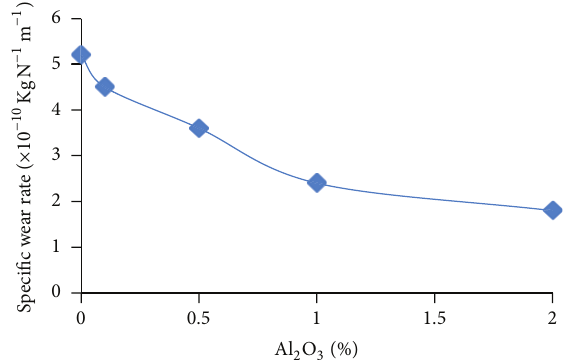
Figure 15: Variation in specific wear rate of EN-coatings as a function of Al 2 O 3 with surfactant (SLS) in EN bath.